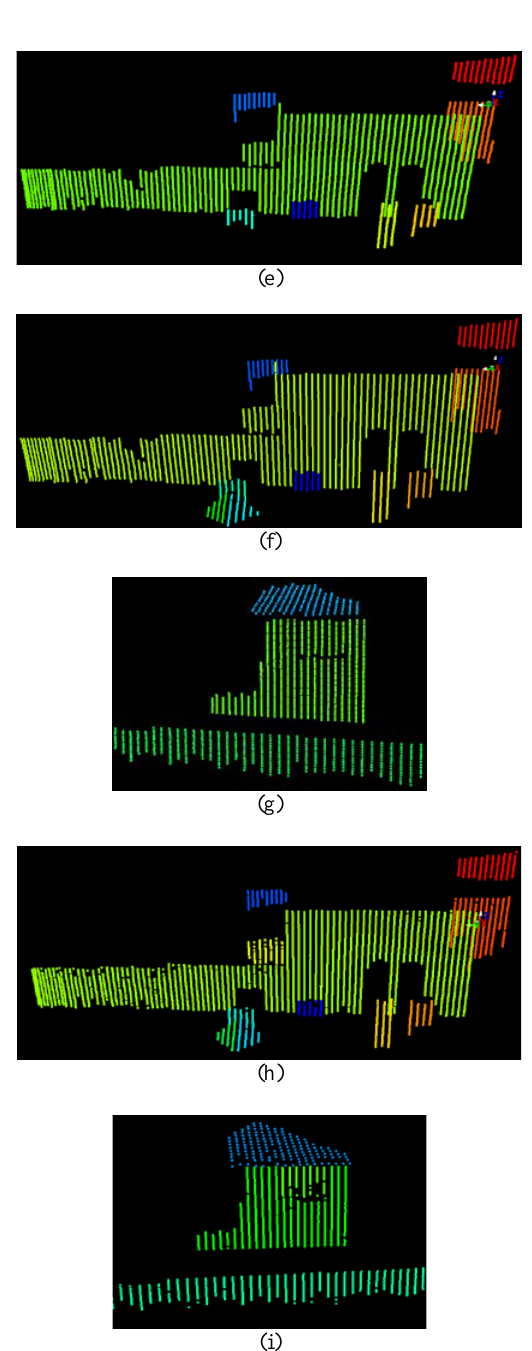
Figure 4 Outputs from different segmentation methods: (a) and (b) RANSAC; (c) and (d) RDPCA; (e) and (g) Cabo; (f) Cabo added; and (h) and (i)